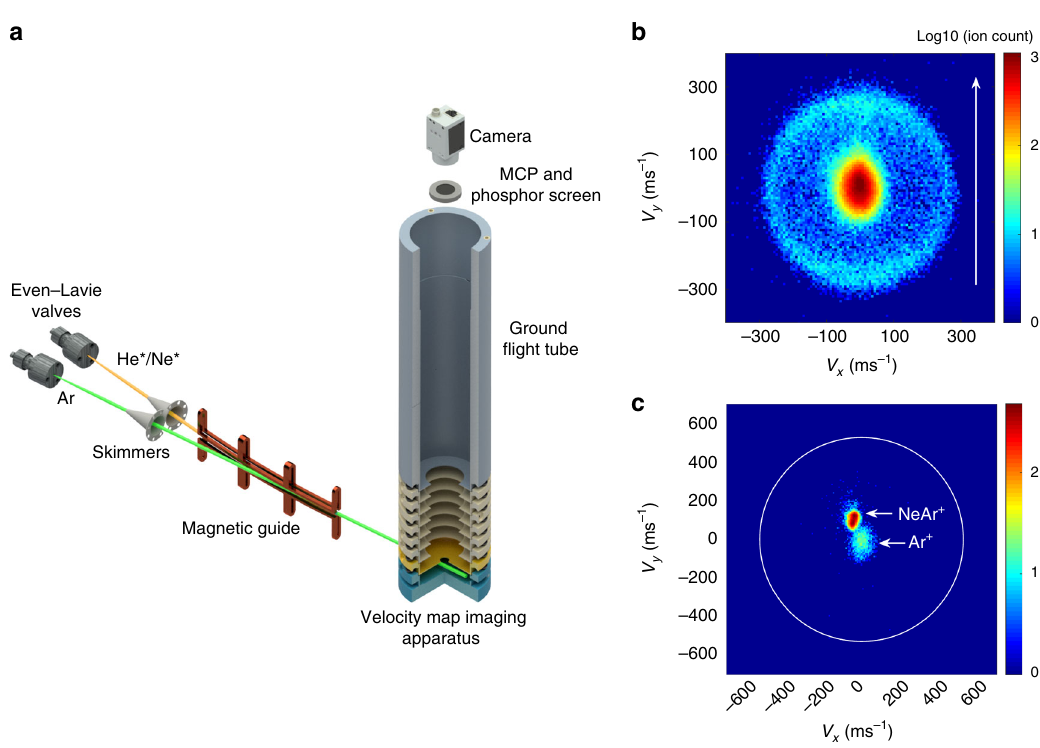
Fig. 3 VMI experiment and results. Schematic setup of the VMI experiment ( a ) together with images for Ar + from He* – Ar collisions ( b ) and Ar + and NeAr + from Ne* – Ar collisions ( c ), collected at collision energies E ∕ k B = 7.8 K and 14.0 K, respectively. The outer ring observed for Ar + (from He* – Ar) corresponds to a kinetic energy comparable to the spin – orbit splitting, cf. Fig. 2, and indicates presence of FFR with lifetimes shorter than the TOF (~12 μ s). The absence of such a ring (the expected position is indicated by the white circle in c ) for Ar + from Ne* – Ar suggests lifetimes signi fi cantly exceeding the TOF. The axes in b , c correspond to Ar + velocities, where the collision axis lies along the green trajectory in a and points up in the VMI images as depicted by the white arrow in b , c . The image in b is taken with temporal mass selection of the Ar + products, while in c the different masses are spatially separated on the detector by an external magnetic fi eld as described in the Methods